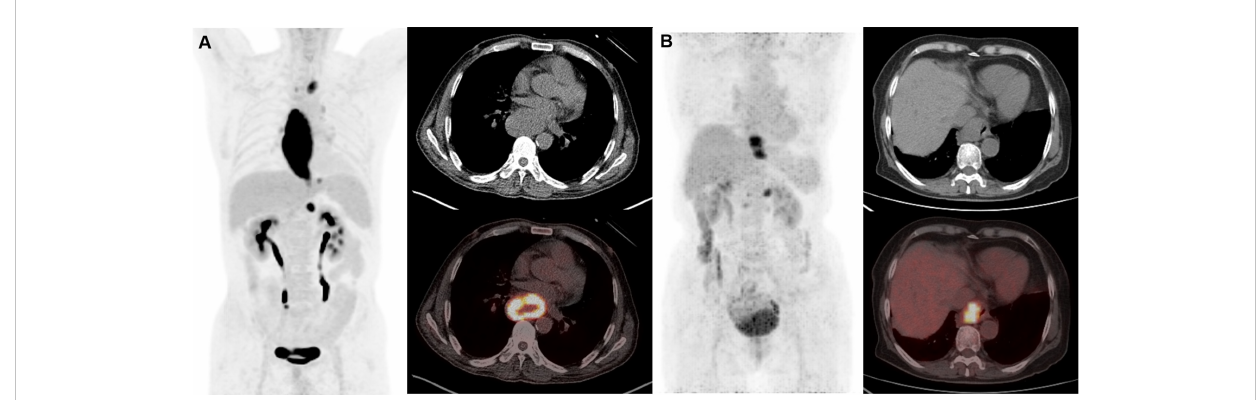
FIGURE 2 Representative cases of metabolic parameters affecting prognosis. Patient A was a 60-year-old man (SUVmax 23.9, SUVmean 8.8, TBR 16.0, TLR 11.3, MTV 213, TLG 1874.7). He had lymph node metastases at initial diagnosis and received chemotherapy. This patient suffered from lung recurrence and died from the disease at 12 months after initial treatment. Patient B is a 76-year-old woman (SUVmax 8.7, SUVmean 4.6, TBR 6.4, TLR 4.5, MTV 22.9, TLG 104.9). She had lymph node metastases at initial diagnosis and received radiotherapy and chemotherapy. This patient remains progression free for 96 months and is still alive until the last follow-up. Compliance with ethical